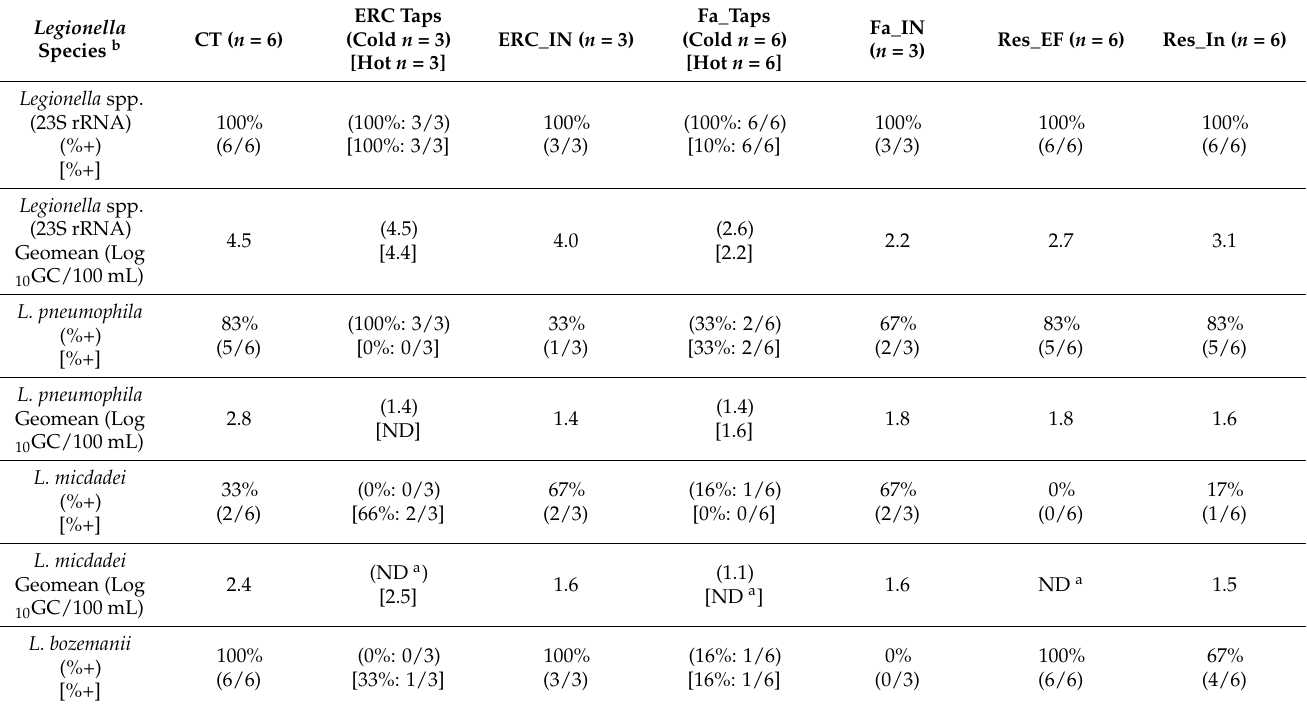
Table 1. Geometric mean concentrations of general Legionella (23S rRNA) and five specific Le- gionella species collected from the drinking water system (RES_IN, RES_EF, Fa_IN, Fa_Taps, ERC_IN, ERC_Taps) and the cooling towers